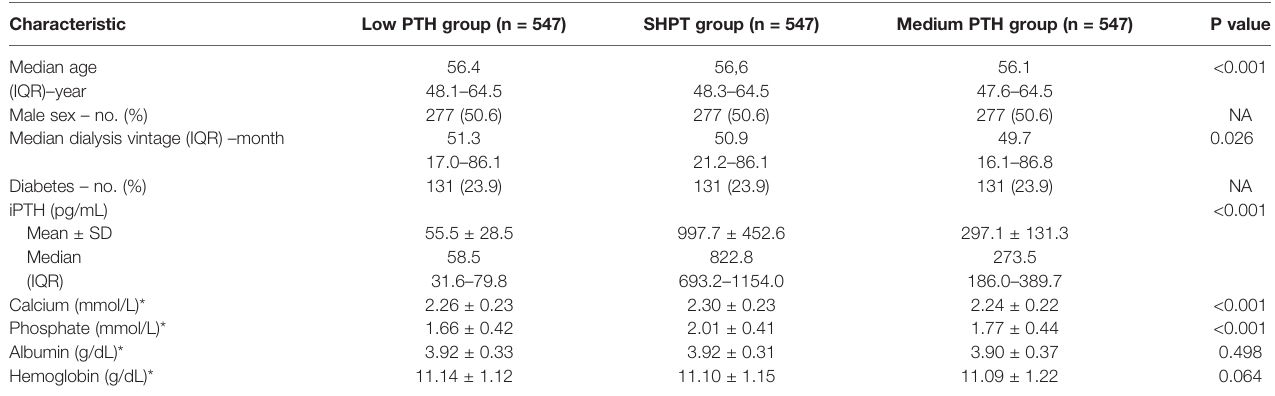
TABLE 3 | Characteristics of the patients in three matched groups: low PTH, SHPT, and medium PTH groups. Characteristic